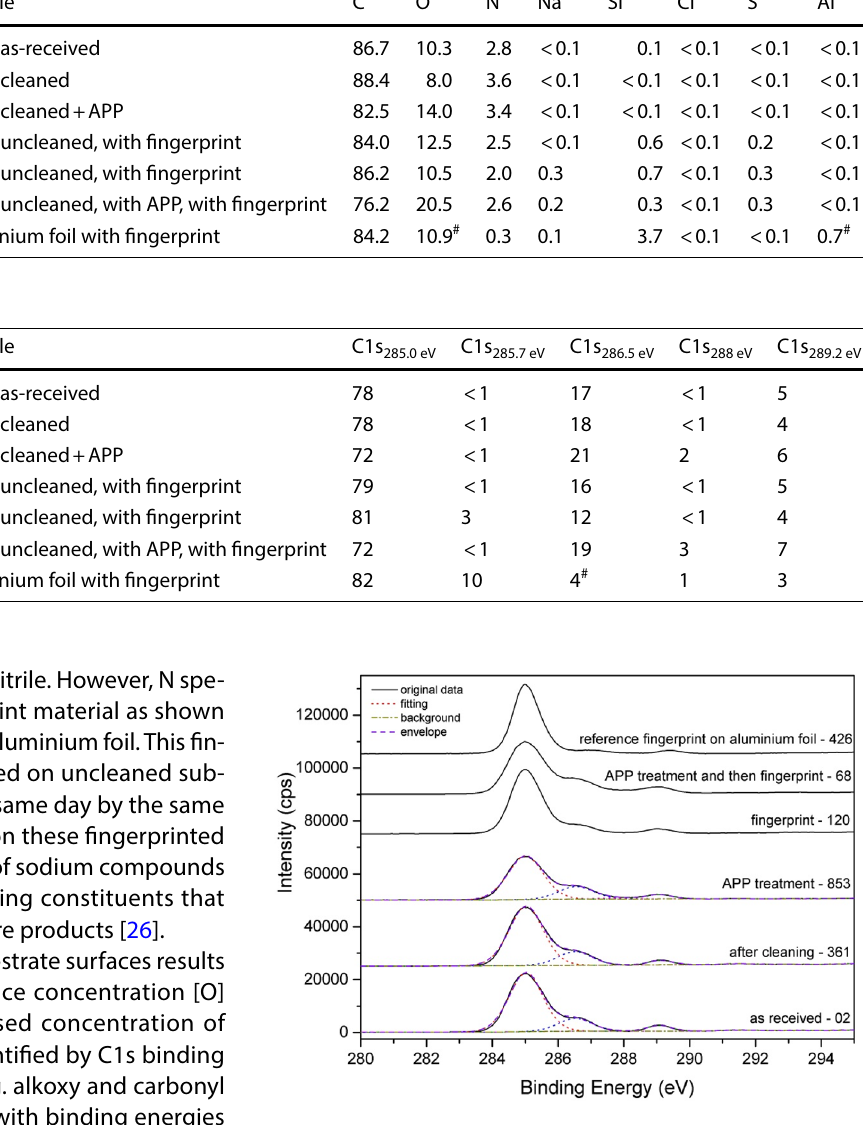
Fig. 10 XPS detail spectra in the C1s region for specimens listed in Tables 2 and 3, i.e. 8_E2, as-received; 8_E2, cleaned;